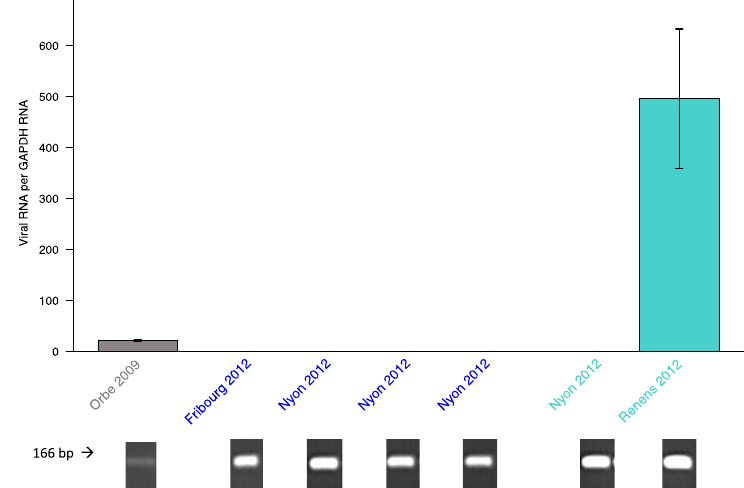
Figure 4. Discordance between qPCR and PCR assays. qPCR results of the wild individuals where PCR detected viral presence. Five of the previously positive samples showed no detection of the virus. Bars show the mean relative viral load per sample ± standard error. The colors describe the populations as follows: wild populations (gray), founding populations of evolution lines before maintenance in the lab (blue) and founding populations of evolution lines after maintenance in the lab for 30 generations